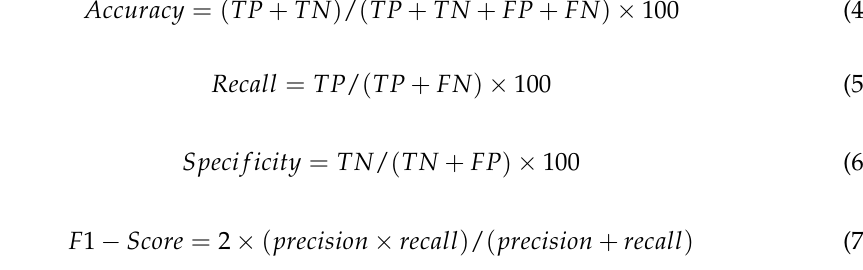
Figure 11. ( a ) Train and validation accuracy; ( b ) train and validation loss graphs of the proposed architecture.